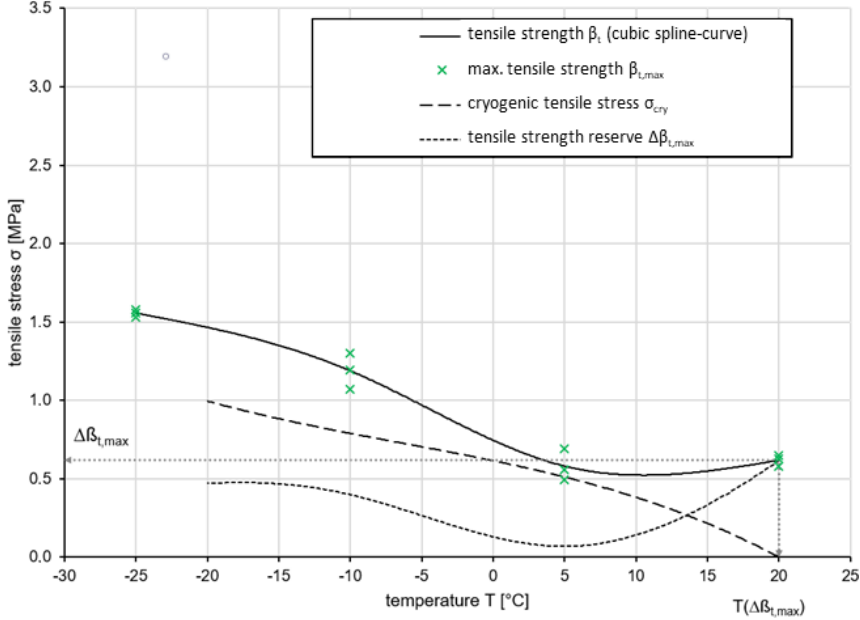
Figure 12. Results of the low temperature behavior of Var